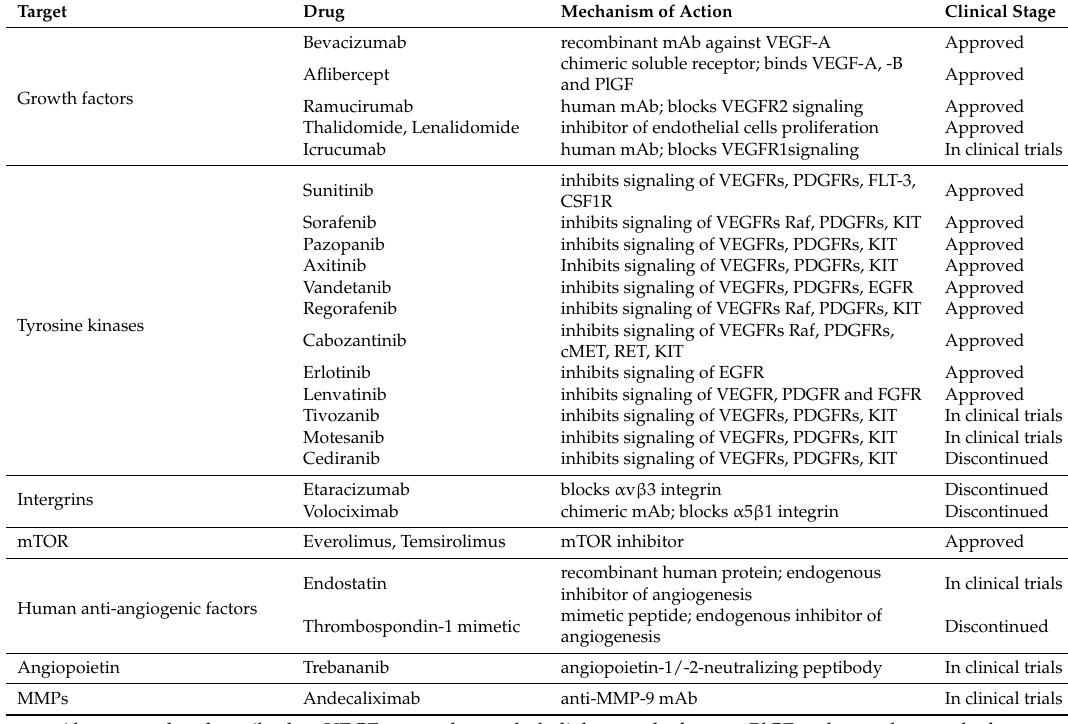
Table 1. Anti-angiogenic drugs that are approved and/or in clinical